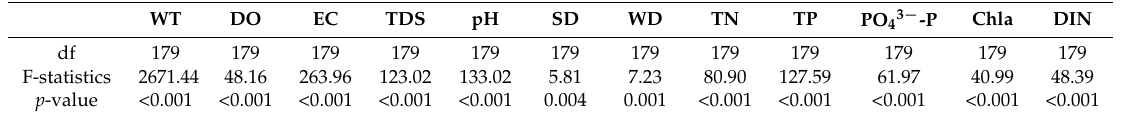
Table 7. The results of ANOVA of temporal